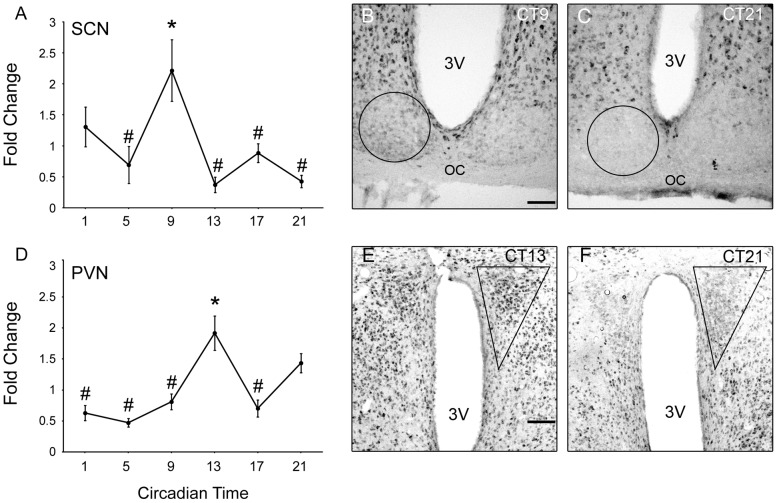
Runx2 protein immunoreactivity is rhythmic in the SCN and PVN of wild type mice.Fold change (mean ± SEM) in Runx2 protein levels measured by immunodensity analyses in the SCN (A) and PVN (D) of mice housed in 24 h DD. Data are expressed as the fold change (mean ± SEM) relative to the overall mean across times of day for all animals for each brain region. . Significant peaks levels of expression (*) compared to nadir points (#; p<0.05). Representative images of sections through the SCN (B and C) and PVN (E and F) at peak (B and E) and nadir (C and F) time points. Traces represent area of analyses. 3V: third ventricle; och: optic chiasm. Scale bar: 100 µm.